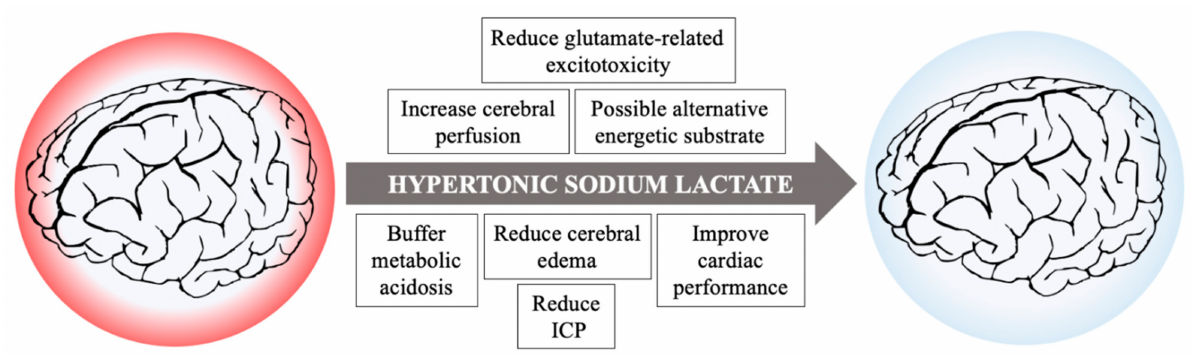
Figure 2. Possible beneficial actions of hypertonic sodium lactate infusion in resuscitated patients after cardiac